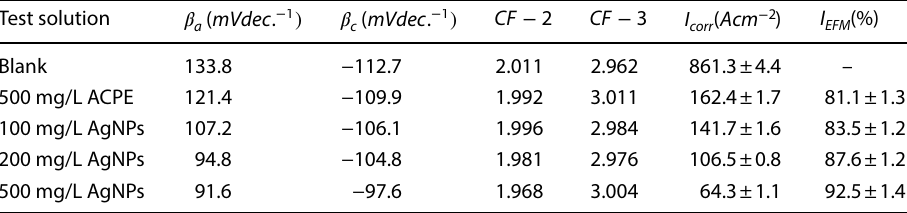
Table 3 EFM parameters for the inhibition of X80 steel corrosion in 1 M HCl containing ACPE and different concentrations of its Et-AgNPs